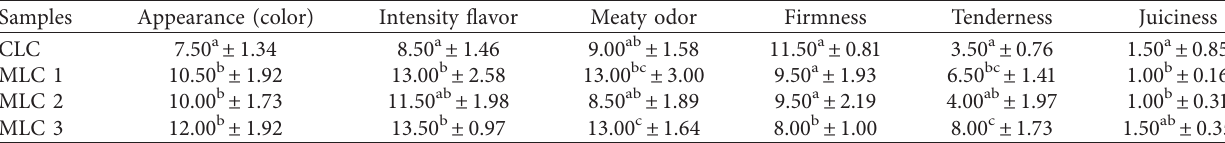
Table 16: Comparative attributes between control layer chicken (CLC) and market layer chicken (MLC) sold at the market. Samples Appearance (color)